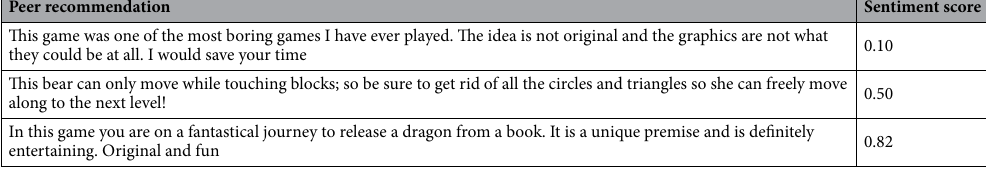
Table 1. Example of peer recommendations and their sentiment